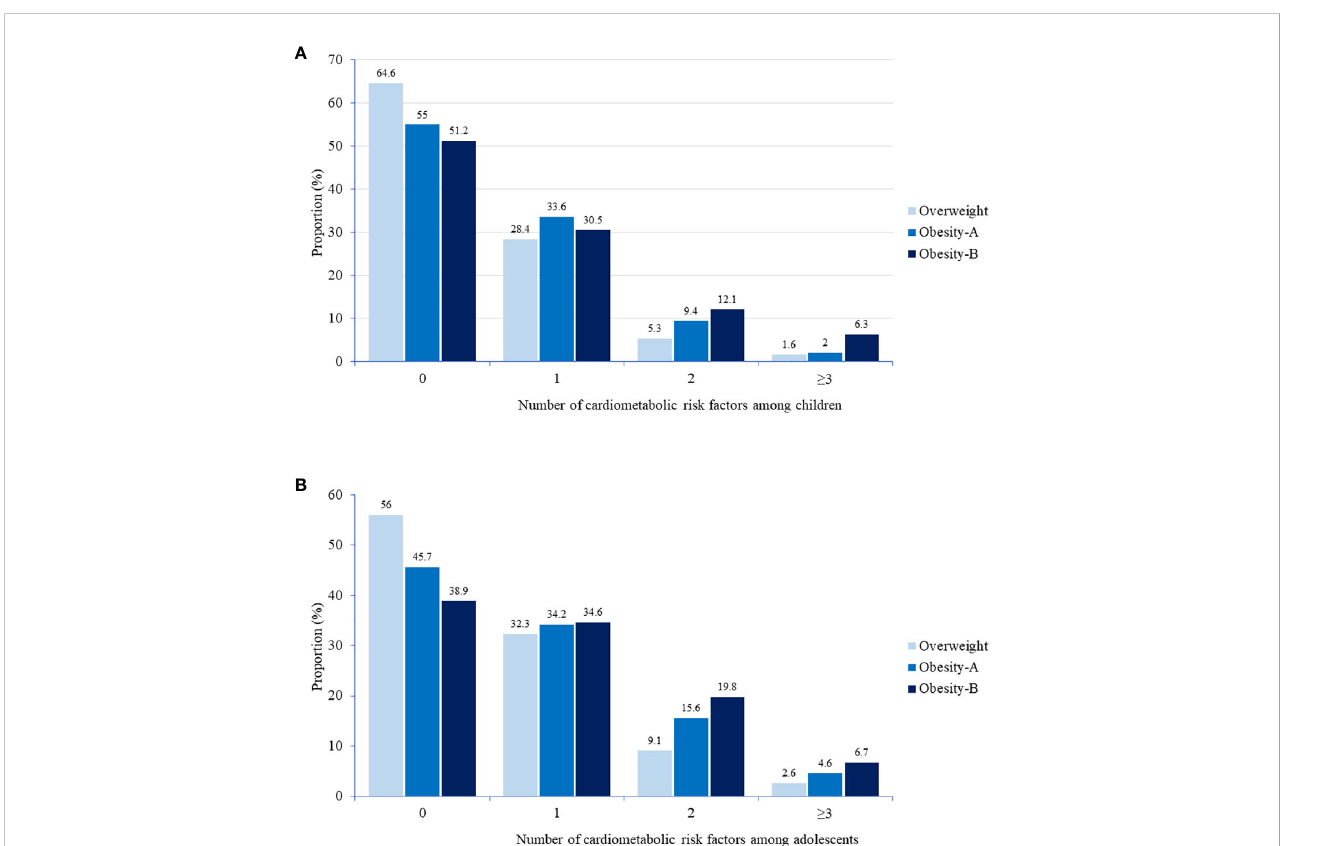
FIGURE 2 Distribution of cardiometabolic risk factors among children (A) and adolescents (B) by weight category. Cardiometabolic risk factors include hyperglycemia (prediabetes or diabetes), high triglycerides, LDL cholesterol, ALT, and systolic or diastolic BP, or low HDL cholesterol. The number of cardiometabolic risk factors increased with the severity of obesity in children (p<0.001) and adolescents (p<0.001). P value for difference between groups was determined by chi square